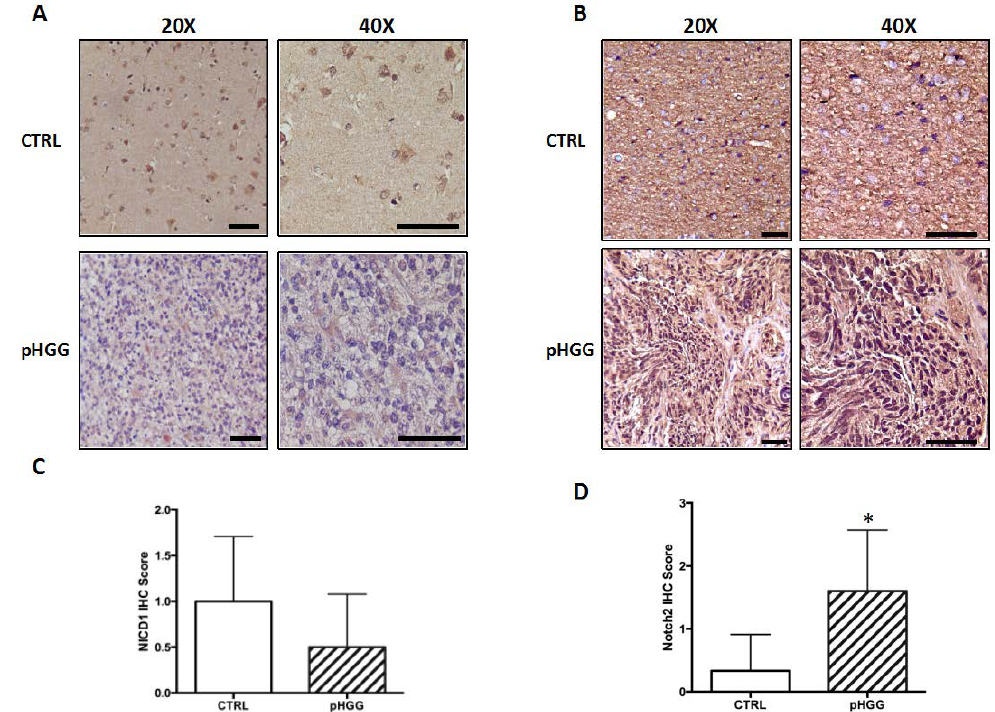
Figure 1. Notch1 and Notch2 expression in pHGG and non-neoplastic brain tissues. Representative images of immunohistochemical (IHC) staining of NICD1 ( A ) and Notch2 ( B ) and relative IHC scores ( C,D ) for nuclear expression of NICD1 and Notch2 in 10 pHGGs and normal brain tissue. * p < 0.05 vs. control (CTRL). Scale bars in ( A , B ): 100 μm.